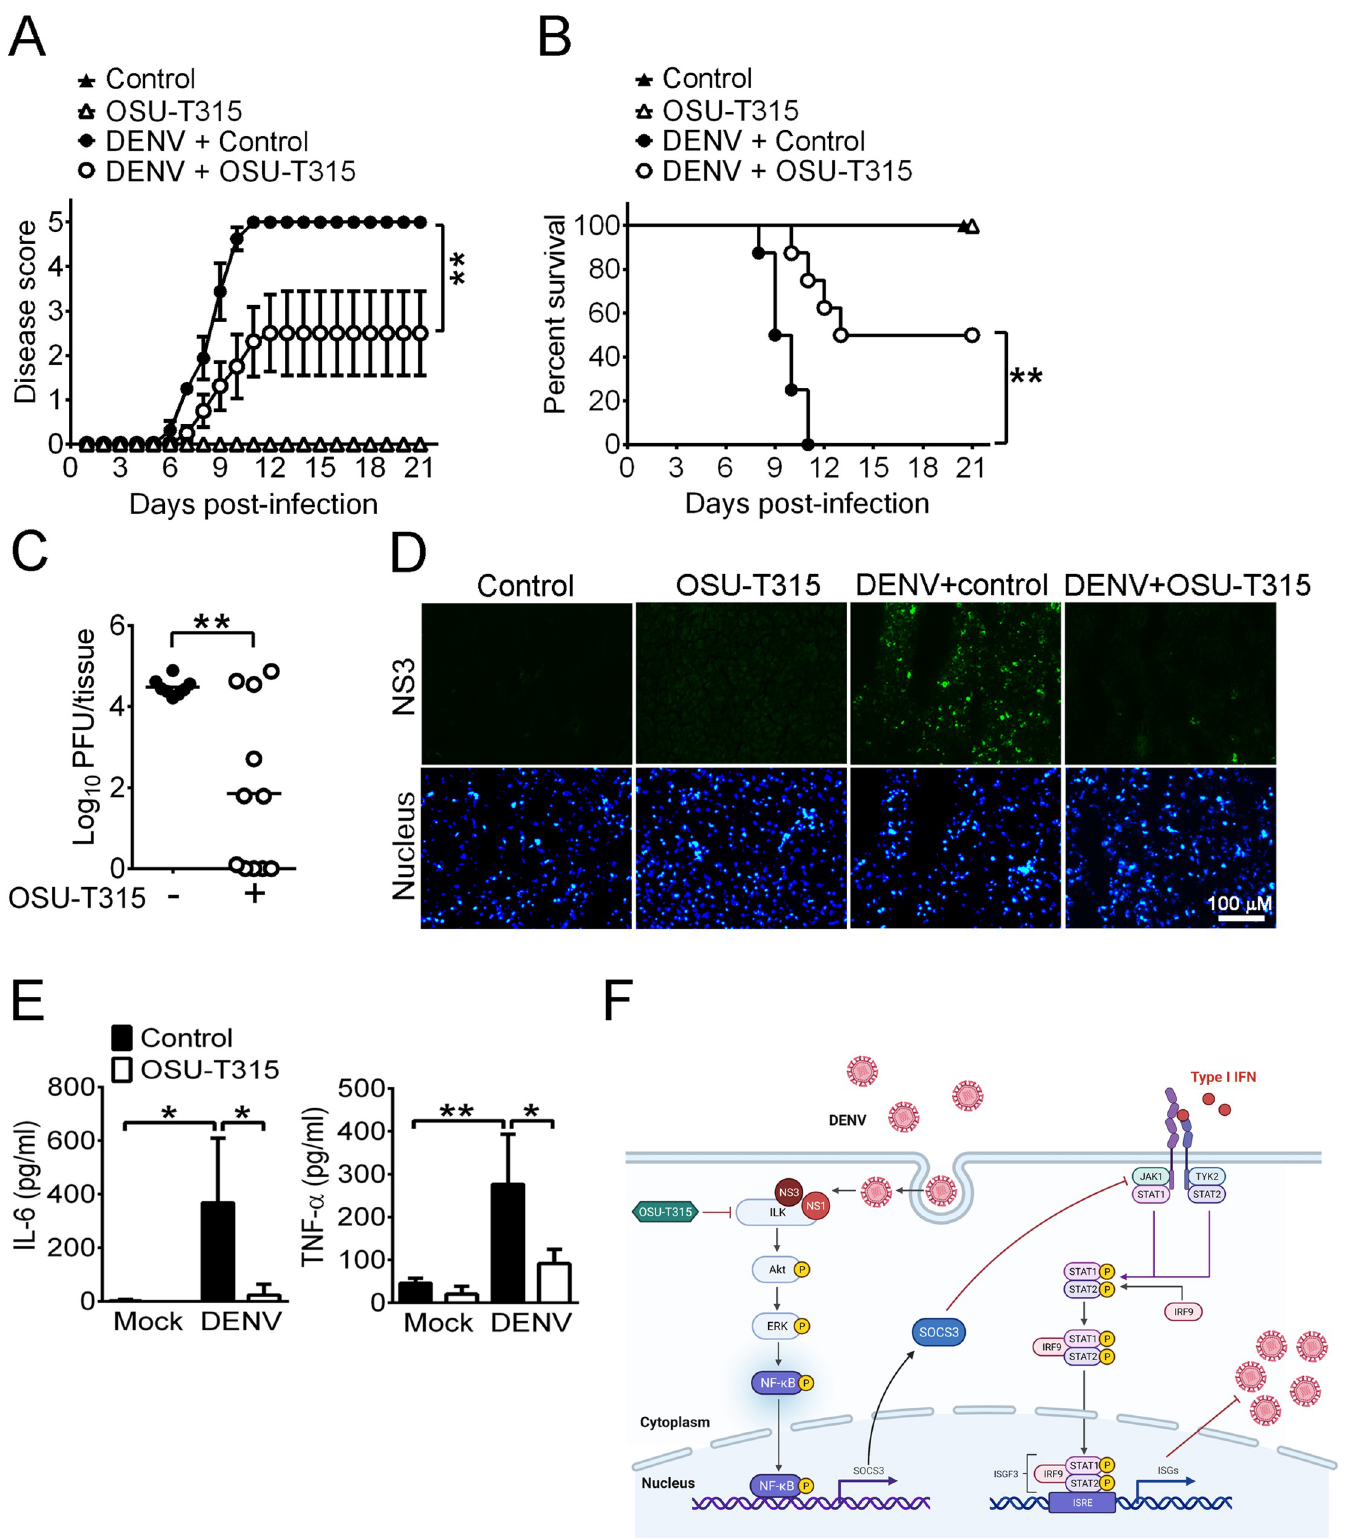
Fig 7. The inhibition of ILK reduces viral loads in the brains and mortality rate of DENV2-infected mice. ( A, B, C, and E ) The 7-day-old C57BL/6 mice were mock- infected or infected with 6 × 10 5 plaque-forming unit (PFU) of DENV and treated without (control or -) or with 12.5 mg/kg OSU-T315. The disease scores ( A ), survival